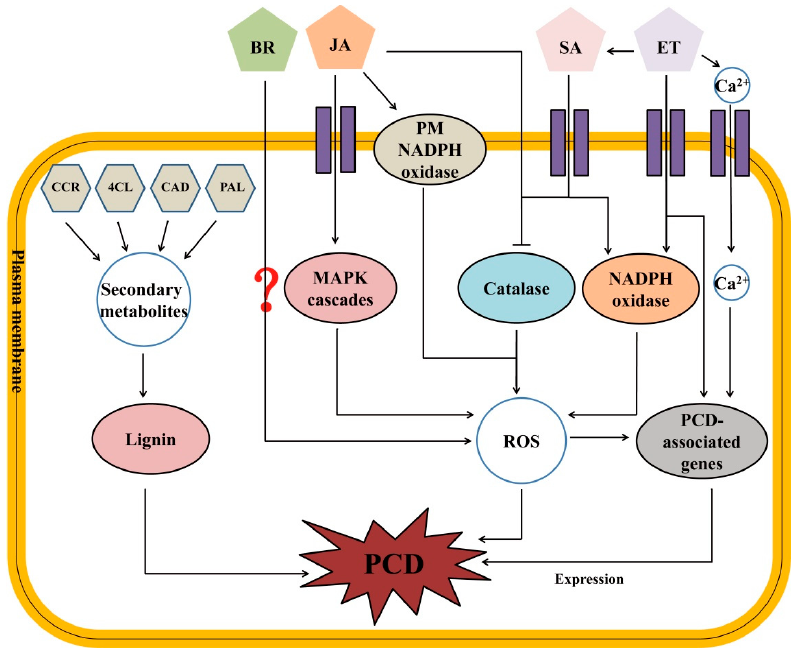
Figure 13. The putative working model for triggering programmed cell death (PCD).